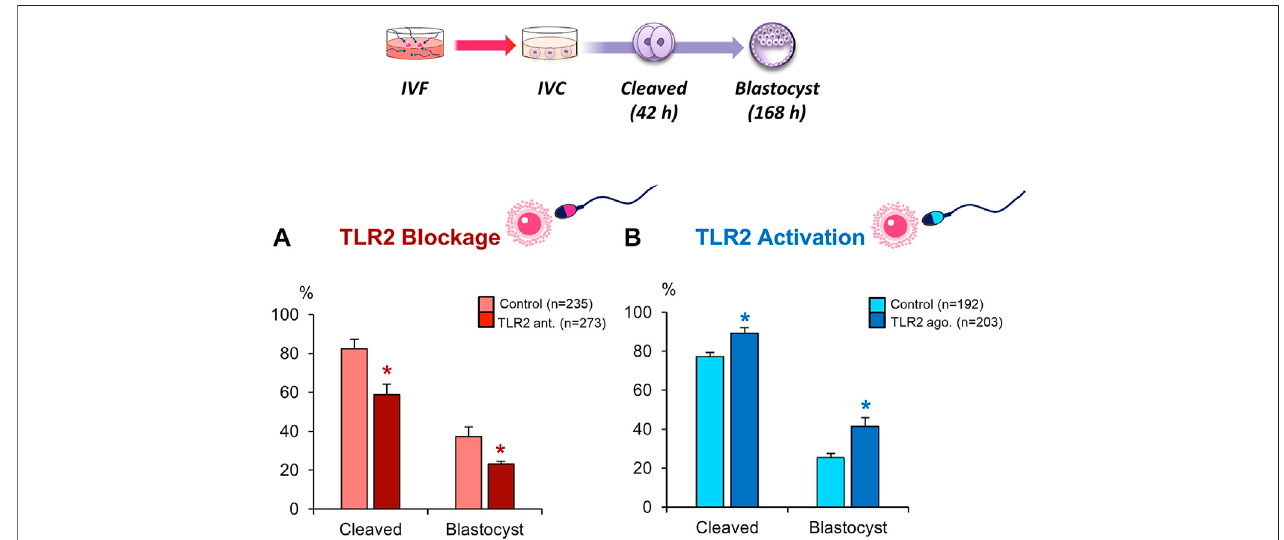
FIGURE 2 | Blockage/activation of sperm TLR2 suppressed/enhanced the cleavage and blastocyst rates in COCs. Sperm were pre-treated by (A) TLR2 antagonist (100 µM) or (B) TLR2 agonist (100 ng ml − 1 ) for 30 min, washed, and co-cultured with cumulus-free(zona-intact) and zona-free oocytes. Percentage of fertilized oocytes observed after 42 h post insemination and blastocyst on Day 7 (Day 0 = day of fertilization). Data reported as means ± S.E.M. Different superscript asterisksdenoteasigni fi cantdifference( p < 0.05).Thenumber ofpresumptivezygotesforeachtreatmentgroup(fromthreeindependentexperiments)isspeci fi ed above each Figure.